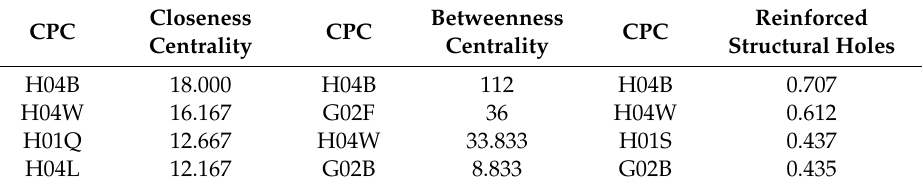
Table 3. 5G Photonic technology for the top 4 Cooperative Patent Classification (CPC codes).